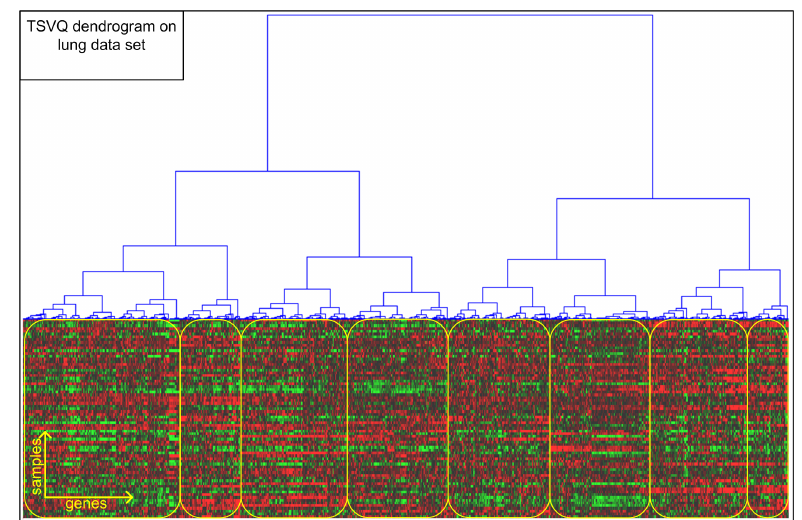
Figure 7: Visualization of dendrogram and microarray for TSVQ on lung . Clusters in the level selected of the dendrogram are